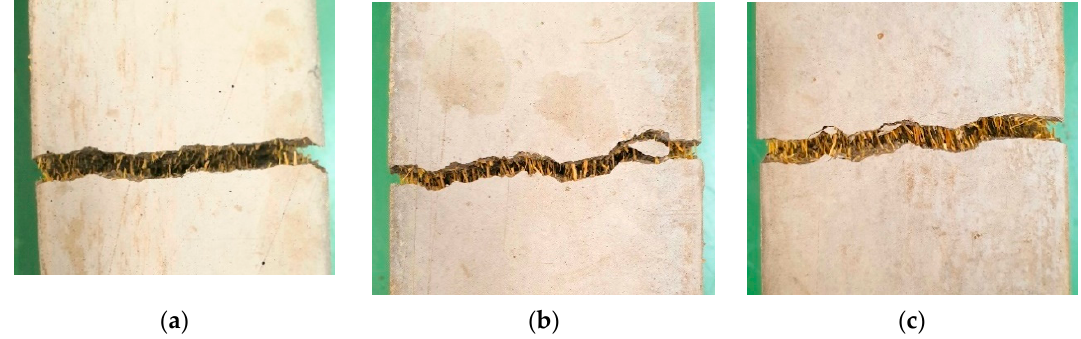
Figure 5. Photographs of test samples after bending tests involving 300 𝜇 m fibers. Fiber content: ( a ) 4 V%, ( b ) 6 V% and ( c ) 8 V%.